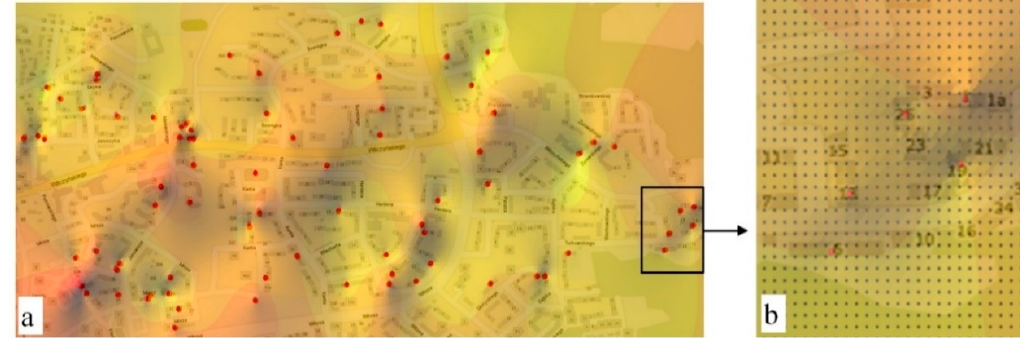
Figure 5. The location of property value zones in the analyzed object, generated based on a GRID structure with 0.0001° resolution (identical scale to Figure 7); ( a ) entire object (2005); ( b ) the size of base fields is equivalent to GRID resolution. Source: own elaboration.